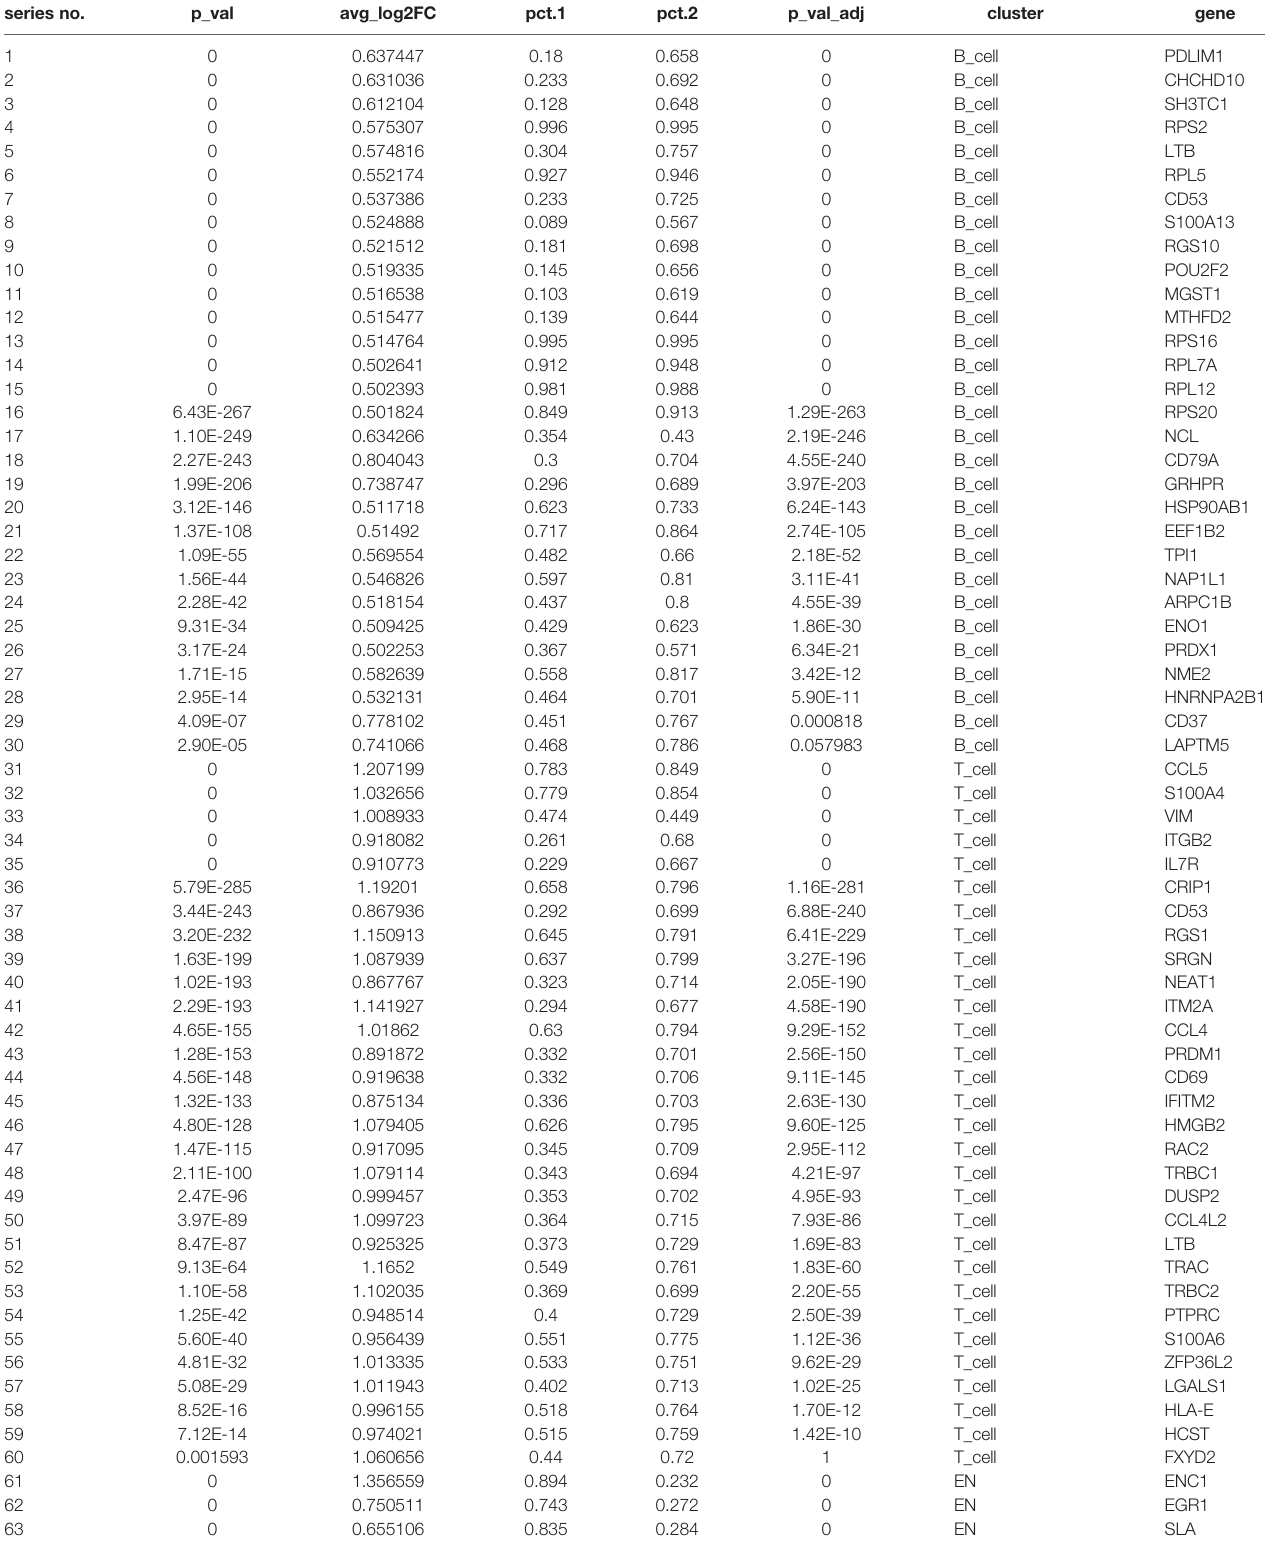
TABLE 1 | The top30 marker genes in scRNA-seq data. series